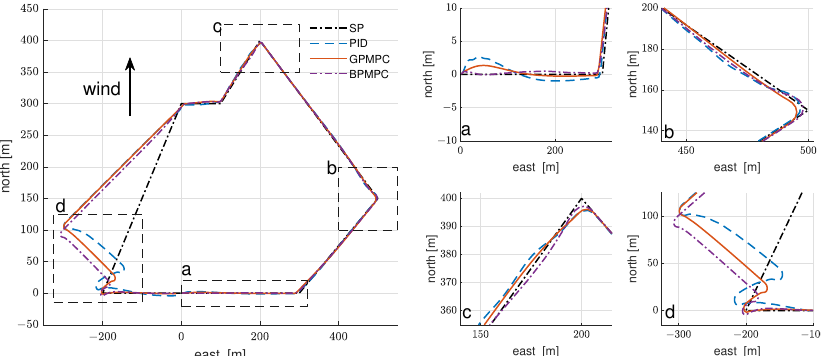
Figure 20. The sailing trajectory under the calm water surface. The black dotted line in the figure is the reference trajectory, the blue dashed line is the PID control effect, the purple dotted line is the BPMPC control effect, and the orange solid line is the GPMPC control effect. The right side shows the zoomed-in view of the local trajectories in the four areas of ( a – d